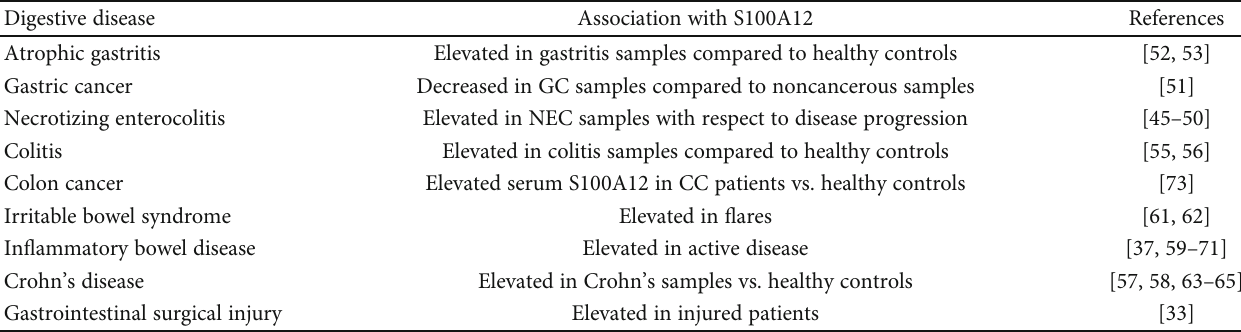
Table 1: Digestive diseases and their association with